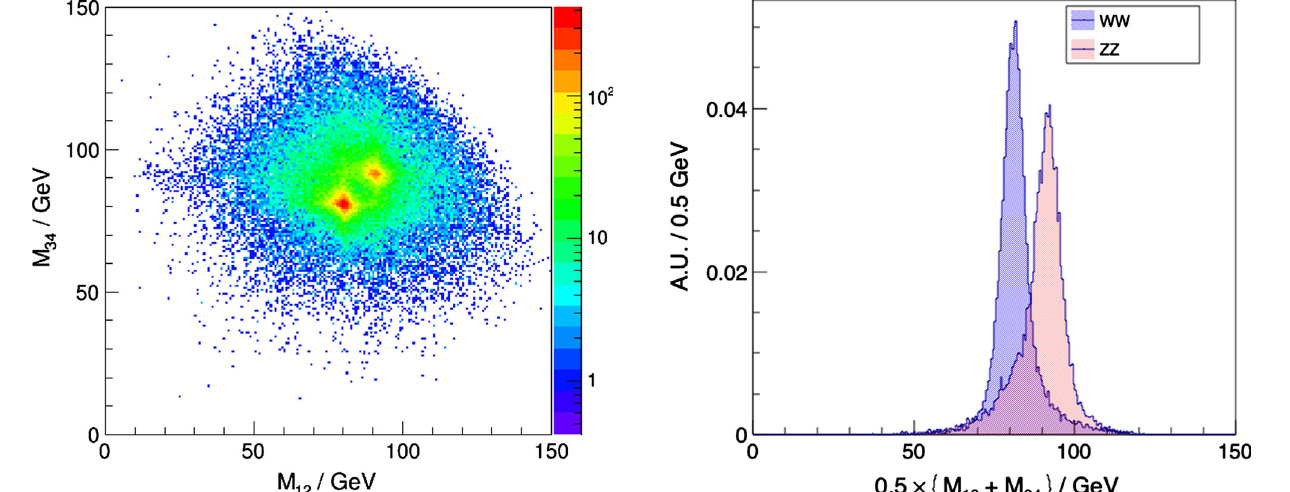
0 . 40% and 27 . 1% ± 0 . 42%, corresponding to the RecoJet and the GenJet plots, see Figs. 9, 10, 11 and